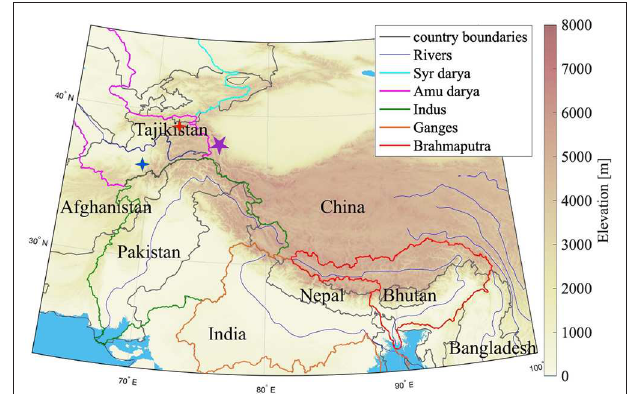
FIGURE 1 | Map of high mountain Asia (HMA) study domain. Elevation obtained from SRTM30 data ( Table 1 ). The light blue area represents the Indian Ocean. The major river basin boundaries are outlined by the colors shown in the legend. High elevation areas receive significant snowfall during the winter season. Purple star shows the test location site discussed in section 5.2. The red and blue crosses mark the snow-on-land and snow-on-ice test sites, respectively discussed in section